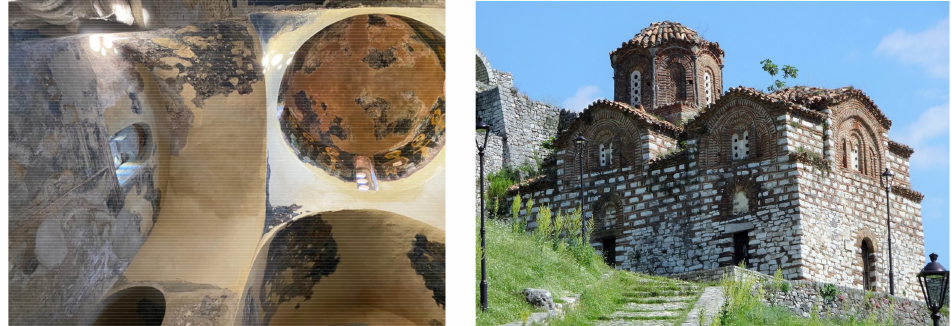
Figure 9. Internal ( left ) and external ( right ) views of the Holy Trinity’s church of